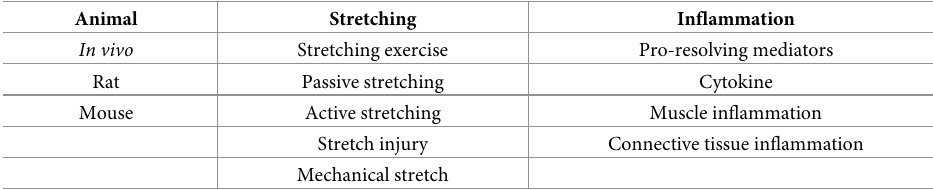
Table 1. Summary keywords employed in the search strategy.